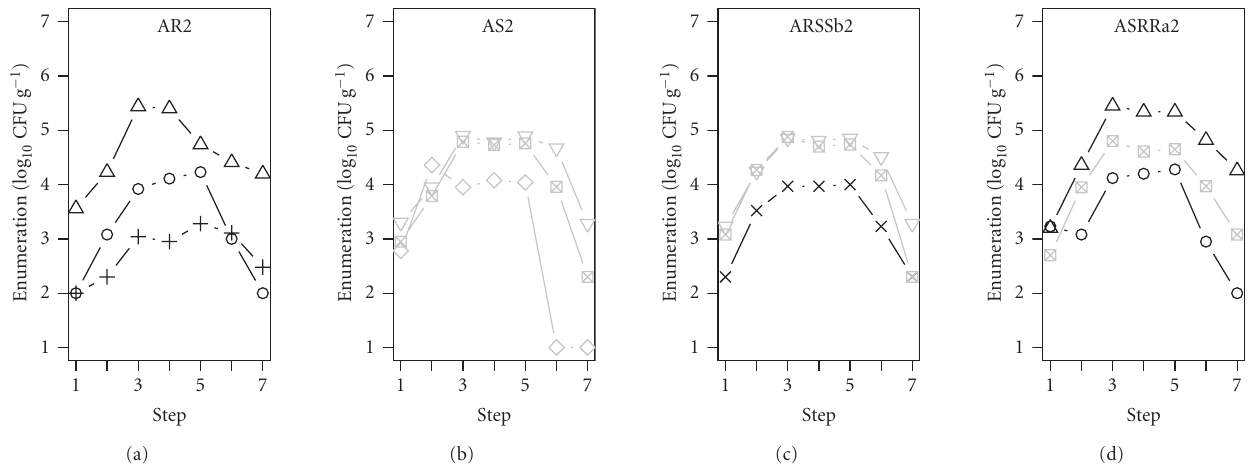
Figure 2: Counts of STEC strains during the cheese manufacture. AR2: 3 AR STEC strains, AS2: 3 NAR STEC strains, ARSSb2: 1 AR and 2 NAR STEC strains, ASRRa2: 2 AR and 1 NAR STEC strains. AR strains: black lines, symbols: (cid:2) , (cid:3) , × . NAR strains: grey lines, symbols: (cid:3) , (cid:4) , (cid:4) . Step 1: milk prior to maturation, Step 3: cheese at moulding stage, Step 5: cheese after drying, Step 7: cheese at the end of ripening (20 days).